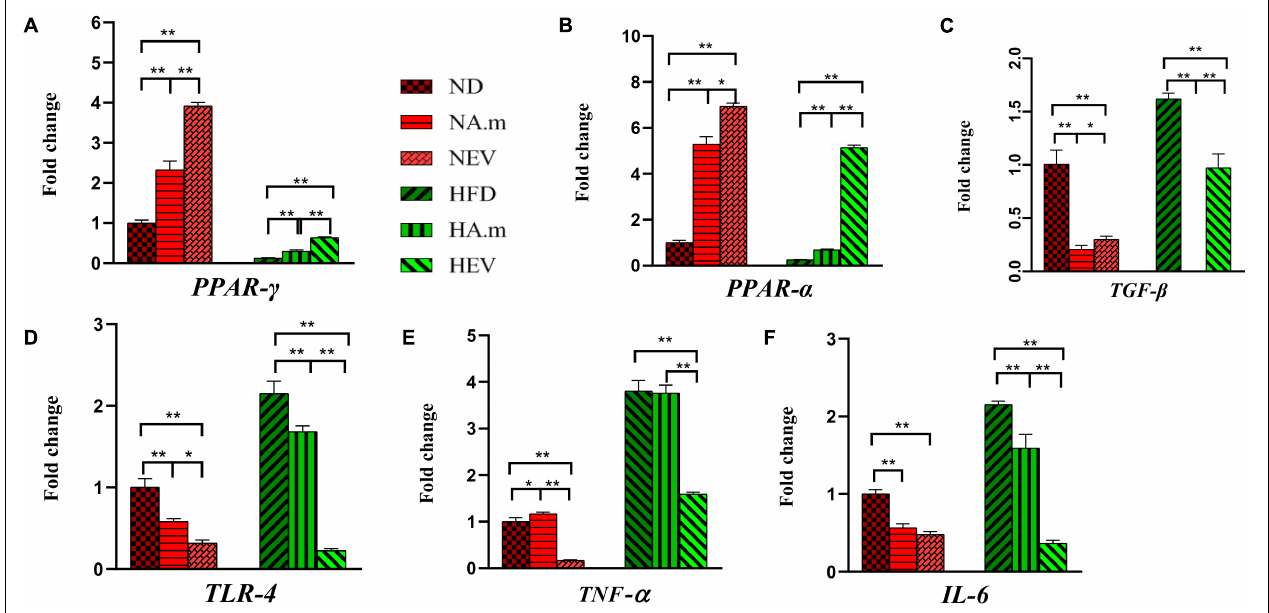
FIGURE 3 | The effect of A. muciniphila and its EVs on mRNA expression of genes in epidydimal adipose tissue in C57bl/6 mice. Relative mRNA expression of (A) PPAR - γ , (B) PPAR- α , (C) TGF- β , (D) TLR-4 , (E) TNF- α , and (F) IL-6. Data are normalized using HPRT as control gene. ∗ P < 0.05 and ∗∗ P < 0.01 were considered statistically significant, respectively. ND, normal diet + PBS; NA.m, normal diet + A. muciniphila (10 9 CFU); NEV, normal diet + EVs (10 µ g protein); HFD, high-fat diet + PBS; HA.m, high-fat diet + A. muciniphila (10 9 CFU); HEV, high-fat diet + EVs (10 µ g